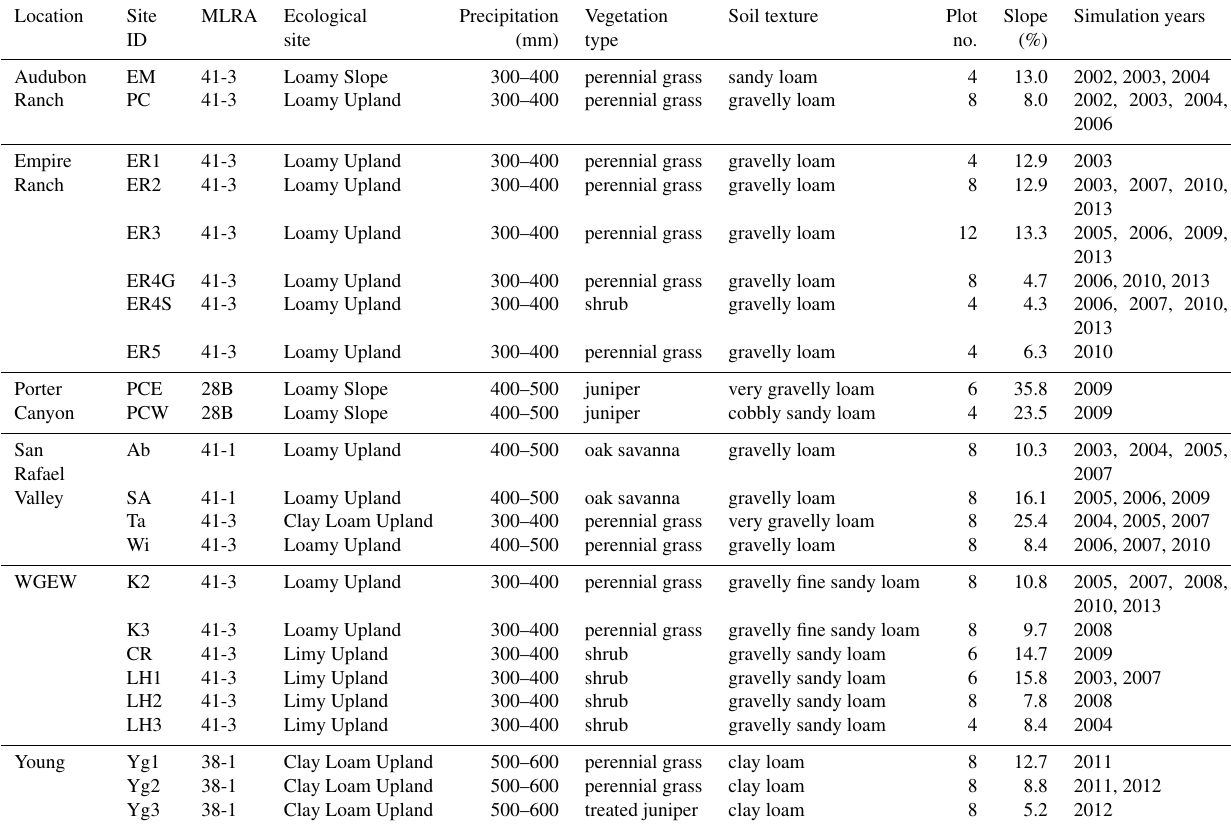
Table 1. Summary of rainfall simulation sites.